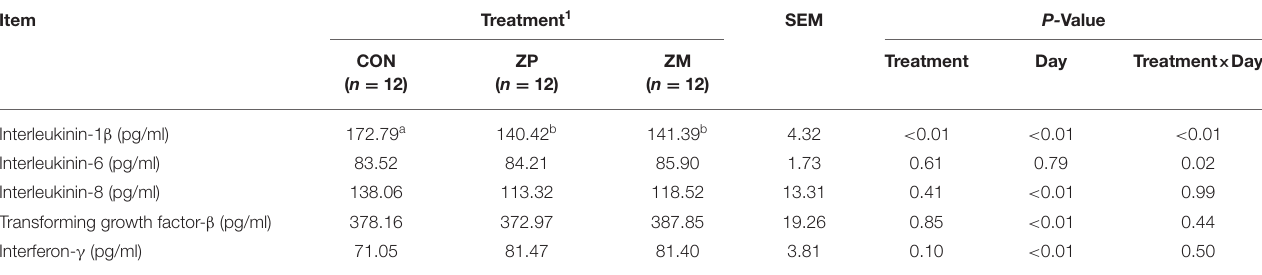
TABLE 6 | Effects of organic zinc sources on concentrations of plasma cytokine in dairy calves during the first month of life (Experiment 2).